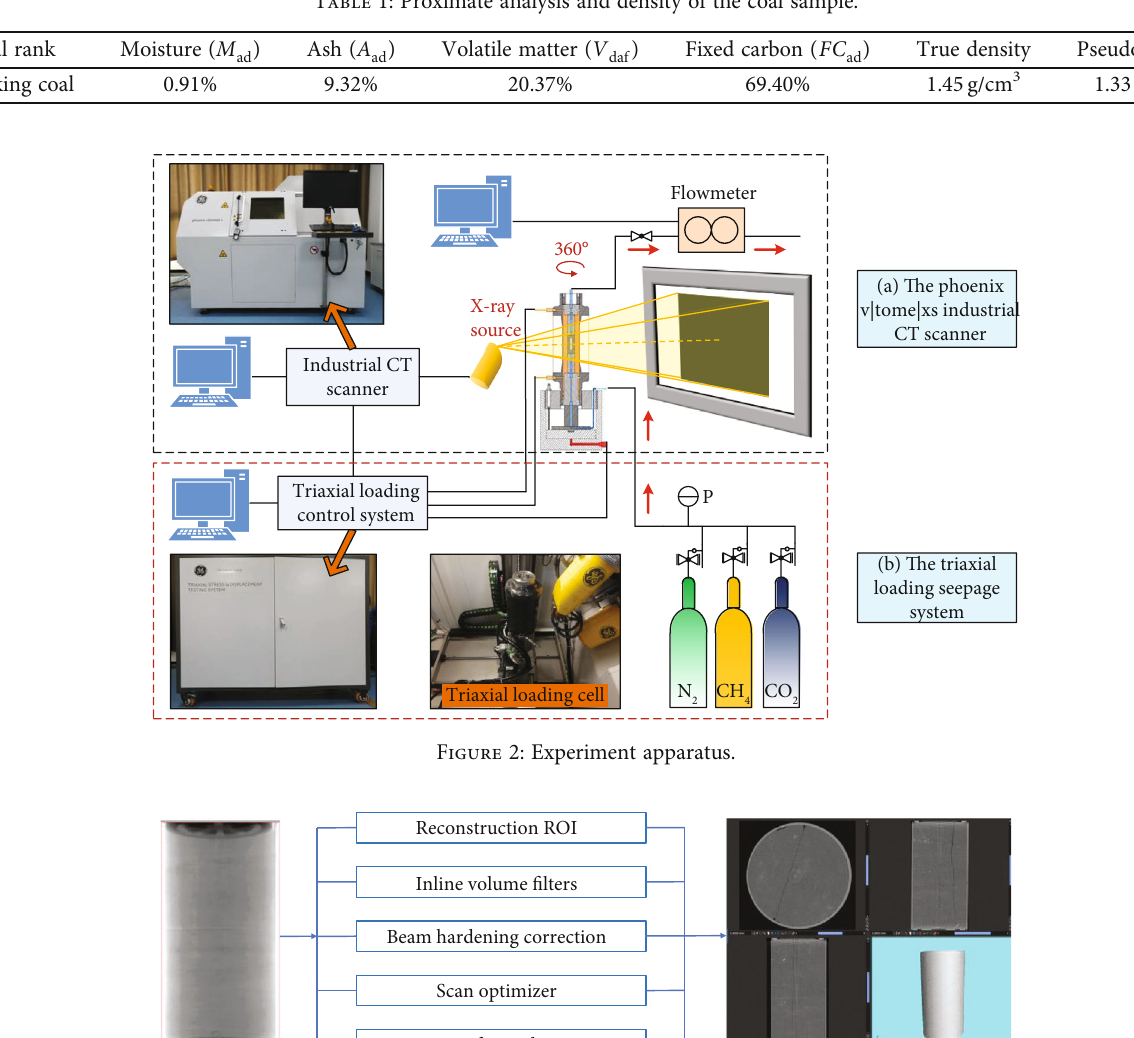
Table 1: Proximate analysis and density of the coal sample.